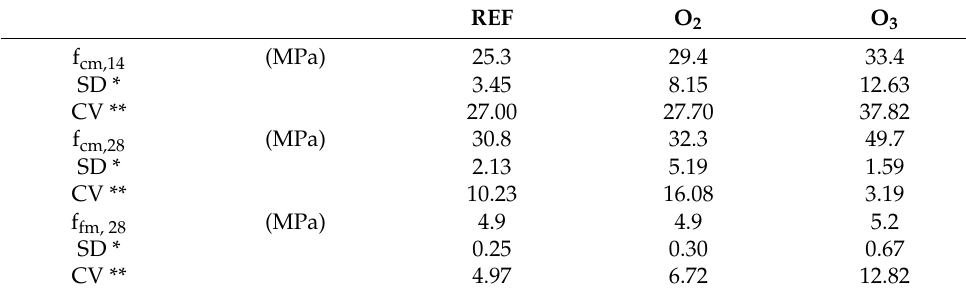
Table 5. Mechanical properties of the tested concretes.